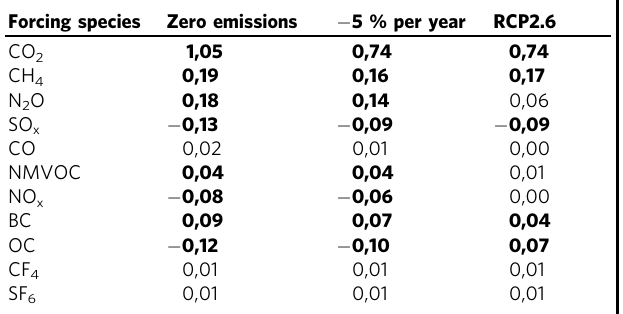
Table 2 Global temperature implications.